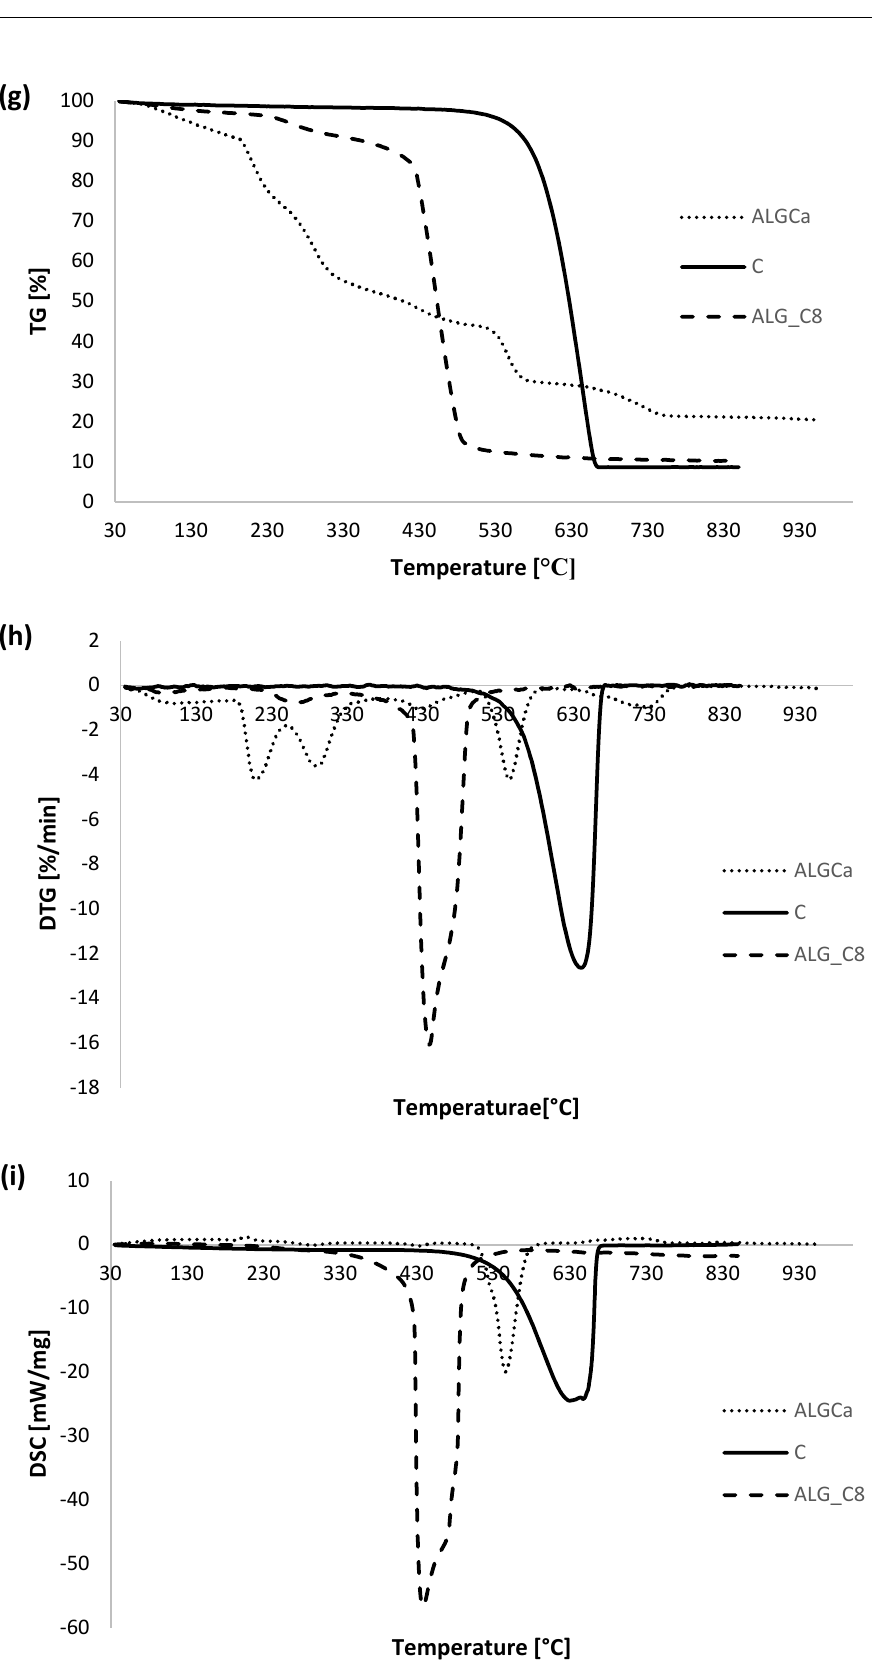
Figure 8. Comparison of TG ( a , d , g ), DTG ( b , e , h ) and DSC ( c , f , i ) curves for C, ALG_Ca, ALG_C2, ALG_C4, and ALG_C8 materials.